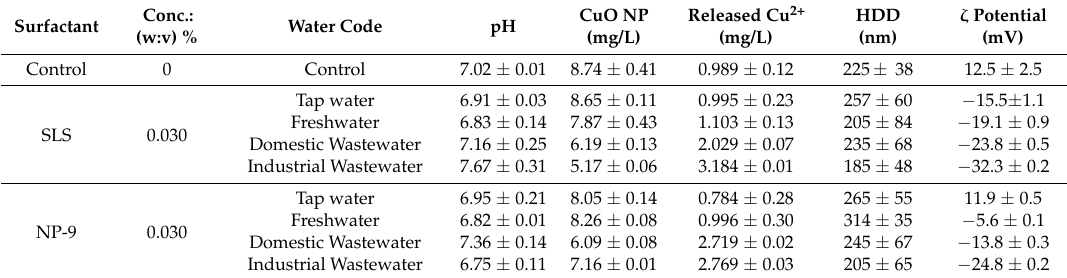
Table 1. Characteristics of synthetic and environmental